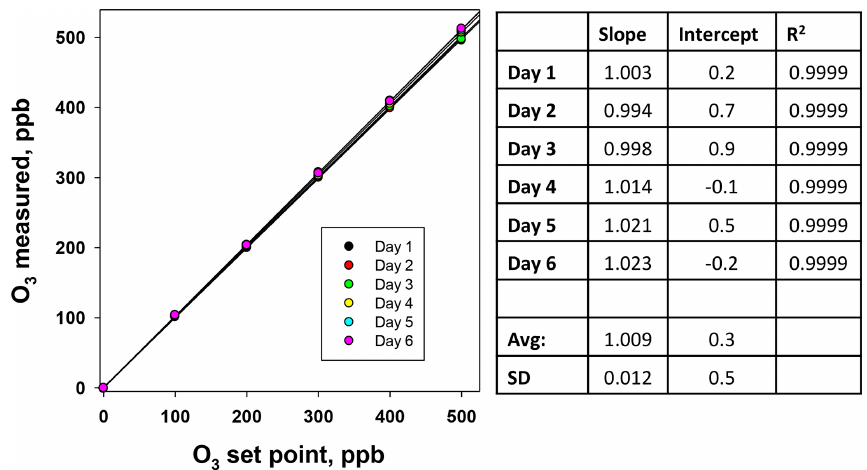
Figure 9. Plots of the O 3 measured vs. the O 3 set point in a Model 714 NO 2 / NO / O 3 calibrator on six consecutive days. Regression slopes and intercepts are given in the panel on the